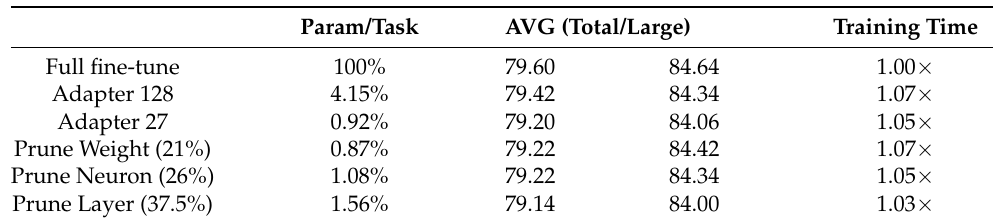
Table 2. Winning ticket of different pruning schemes in test results on GLUE test sets using GLUE server and the percentage of parameters trained. Average results on all GLUE datasets and average results on large datasets in GLUE (SST-2, QQP, MNLI, MNLI mm , QNLI). Training time of all task in GLUE, with Full fine-tune (4 h) as base.